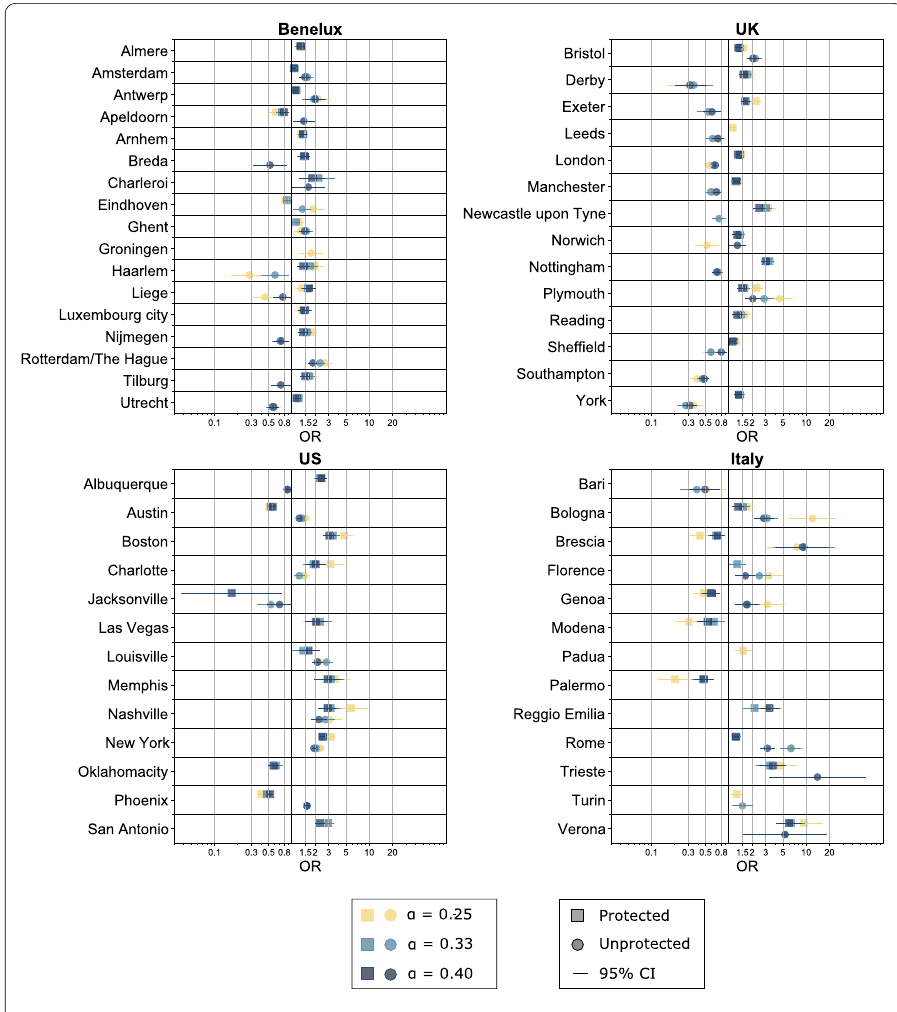
Figure 6 Odd Ratios of minimal logistic models, for all cities in the sample. The charts present estimated ORs of minimal logistic regressions, where the target variable is the binarized σ s regressed against a categorical variable for the protection level of the street (three classes: Noprotection (baseline), Protectedcycleway and Unprotectedcycleway ). The models are run for each city separately. The squared markers are the point estimates for Protectedcycleway and the circular markers are the points estimates for Unprotectedcycleway . The straight lines represent the estimated 95% confidence interval for the corresponding OR. Only statistically significant ORs (significance level 0.95) are pictured. For each city, the minimal model are estimated on three different sample selections, with the threshold α corresponding to 0.25 (yellow), 0.33 (light-blue) and 0.40 (dark blue). The ORs are computed exponentiating the corresponding estimated coefficients. Only cities with at least one statistically significant ORs are